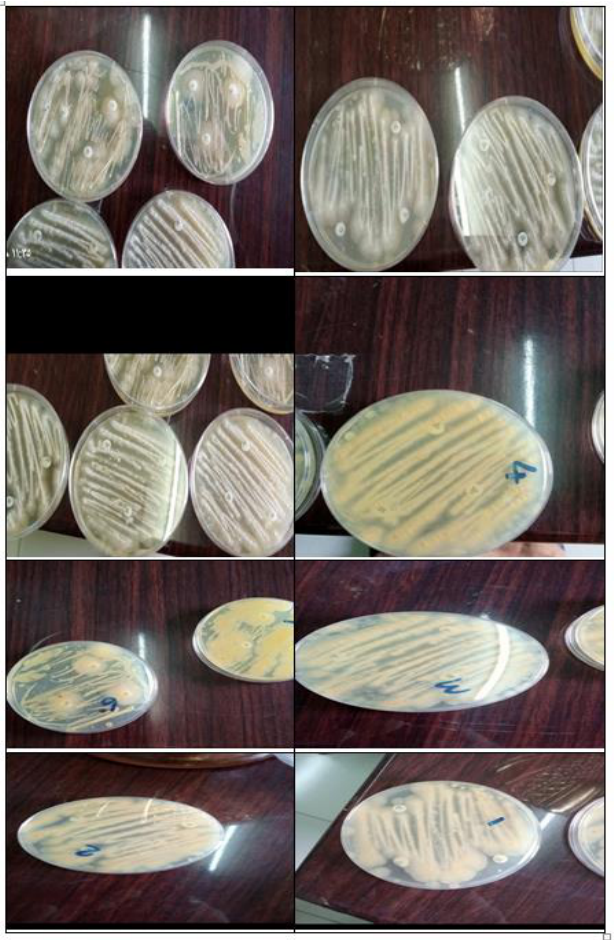
Fig. 1. Effect of antibiotic types on the growth of Streptomyces sp isolates Antibiotic inhibitory capabilities of Streptomyces populations differed between locales. Competitive 'hot spots' that support Streptomyces populations that are effective inhibitors of resource rivals could be competitive 'hot spots' that have selected for Streptomyces populations that are broad and very potent inhibitory phenotypes.